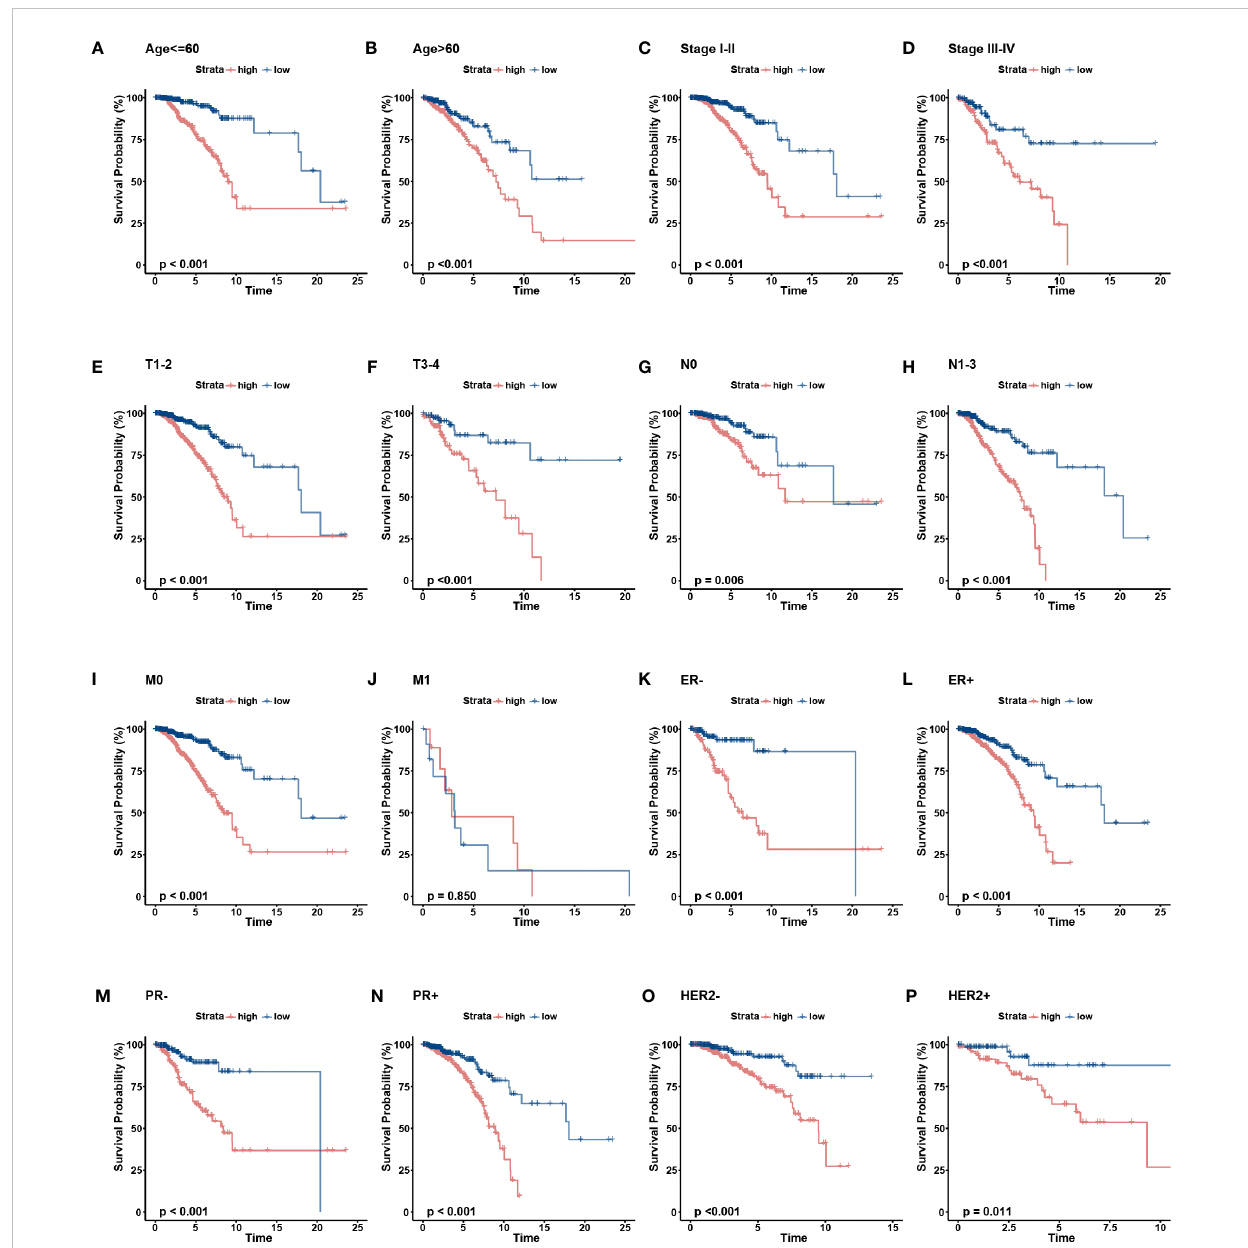
FIGURE 6 The OS KM curves of the two risk groups strati fi ed by the clinicalpathological factors. (A-B) Age, (C-D) Stage, (E-F) AJCC T stage, (G. H) , AJCC N stage, (I, J) AJCC M stage, (K, L) ER status, (M, N) PR status, (O, P) HER-2